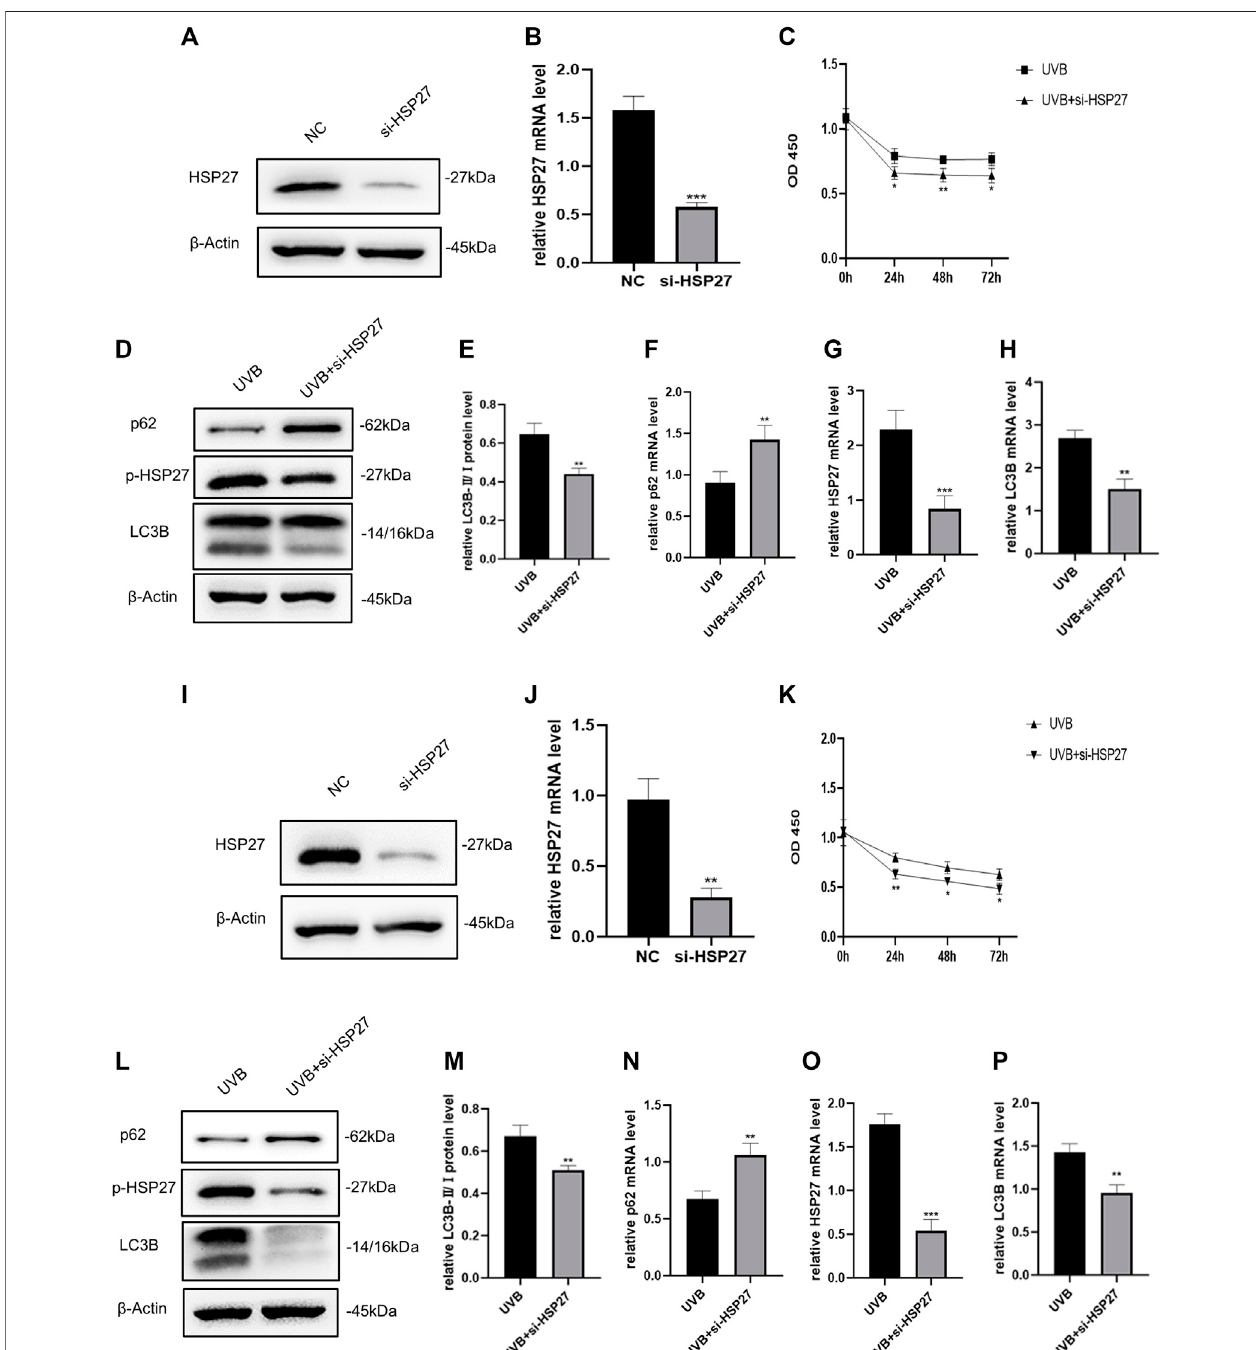
FIGURE 2 | Effects of HSP27 knockdown on cell activity and autophagy under UVB irradiation. (A,D) HSP27, p-HSP27, p62 and LC3B protein expressions were detectedbyusingWesternblottinginHEKsafterHSP27geneknockdown,regarding β -actinasareference. (B,F – H) HSP27,p62andLC3BmRNAlevelsweredetected by using RT-qPCR in HEKs after HSP27 gene knockdown, quanti fi ed by using ACTB as a reference. (C) The proliferation ability of HEKs was detected by the CCK-8 method at 0, 24, 48 and 72 h after UVB irradiation in the control group and the si-HSP27 group. (E) The LC3B- Ⅱ / Ⅰ protein expressions of HEKs after HSP27 gene knockdown. (I,L) HSP27, p-HSP27, p62 and LC3B protein expressions were detected by using Western blotting in HDFs after HSP27 gene knockdown, regarding β - actinasareference. (J,N – P) HSP27,p62andLC3BmRNAlevelsweredetectedbyusingRT-qPCRinHDFsafterHSP27geneknockdown,quanti fi edbyusingACTBas a reference. (K) The proliferation ability of HDFs was detected by the CCK-8 method at 0, 24, 48 and 72 h after UVB irradiation in the control group and the si-HSP27 group. (M) TheLC3B-II/Iprotein expressions ofHDFs afterHSP27 geneknockdown.Alltheresultswereexpressed asmean±SD,and theexperimentwasrepeatedat least three times (* p < 0.05, ** p < 0.01, *** p < 0.005).